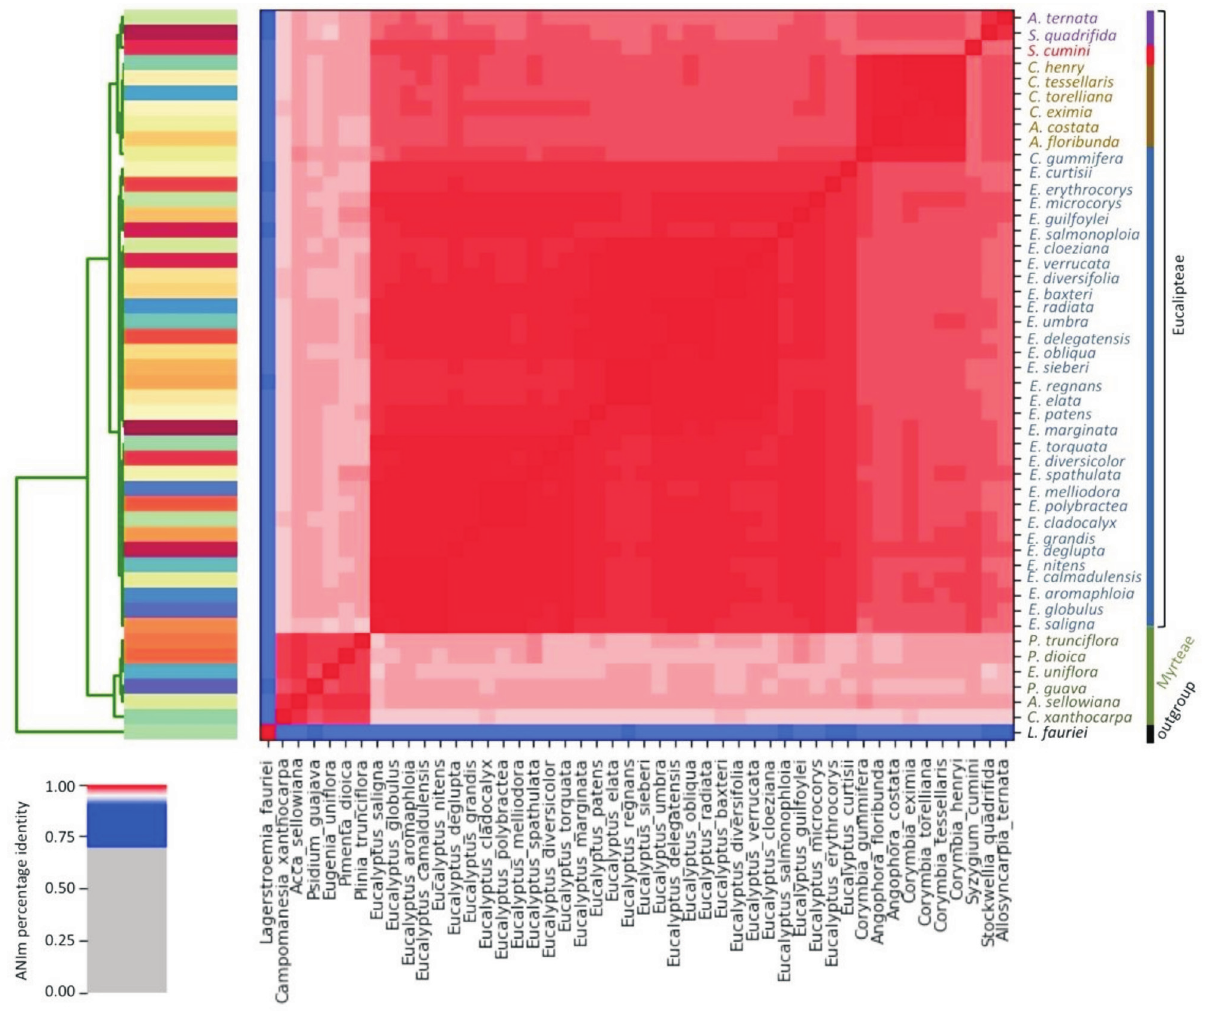
Figure 2 - Heatmap of ANIm percentage identity for 48 Myrtaceae species and the outgroup species Lagerstroemia fauriei (Myrtales: Lythraceae; KT358807). Cells in the heatmap corresponding to 95% ANIm sequence identity are in red color; Cells corresponding to 75% ANIm sequence identity areinblue.Colorintensityfadesasthecomparisonsapproach95%ANImsequenceidentity.Colorbarsaboveandtotheleftoftheheatmapcorrespondto the species level that was